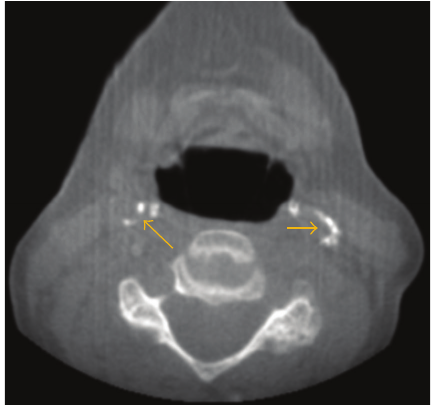
Figure 7: Degenerative changes (osteoarthritis) of the C3-C4 with osteophyte formation are seen on this coronal image.